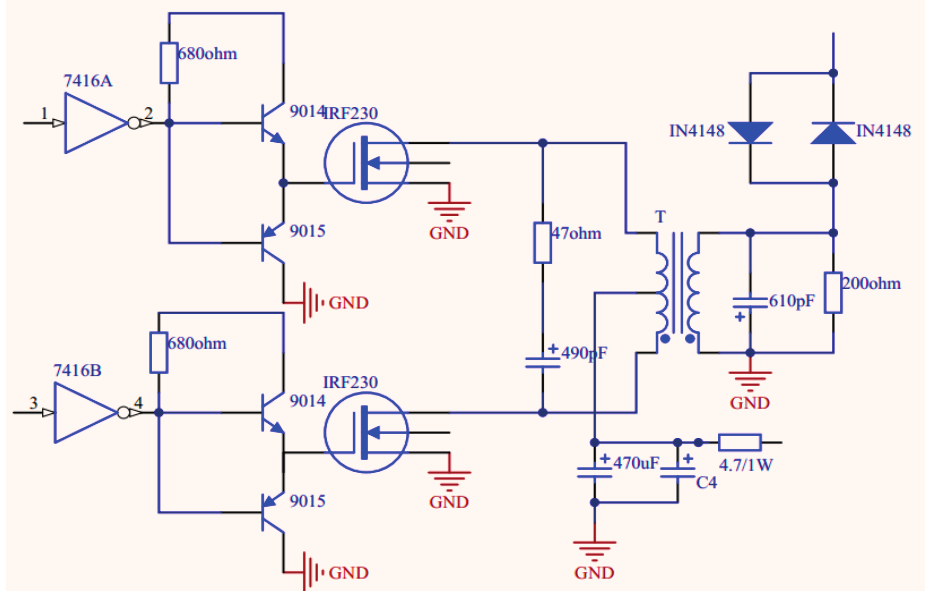
Figure 5. The signal-radiation electric circuit of the detection